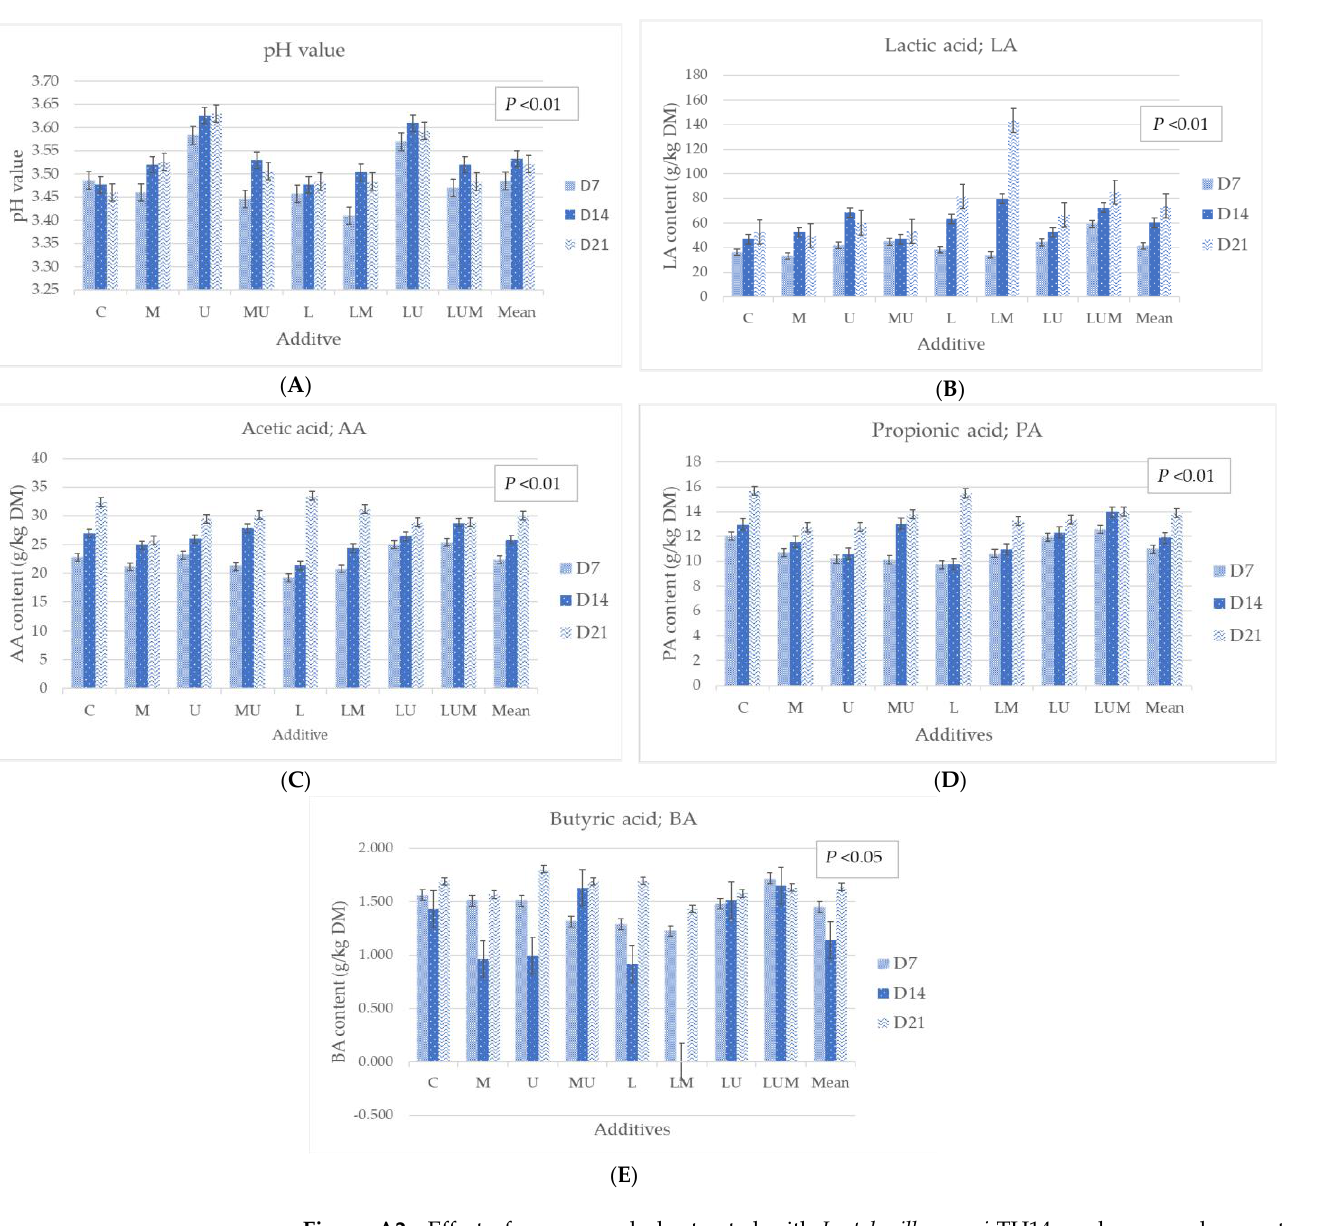
Figure A2. Effect of cassava pulp by treated with Lactobacillus casei TH14, molasses, and urea at different days and the mean of each day of fermentation on ( A ) pH value, ( B ) lactic acid; LA, ( C ) acetic acid; AA, ( D ) propionic acid; PA, and ( E ) butyric acid; BA. CON = no additive, M= treated with molasses 4% DM, U = treated with urea 4% DM, UM = treated with urea 4% DM and molasses 4% DM, L = treated with LcTH14 105 cfu/kg FM, LM = treated with LcTH14 10 5 cfu/kg FM and molasses 4% DM, LU = treated with LcTH14 10 5 cfu/kg FM and urea 4% DM, and LUM = treated with LcTH14 10 5 cfu/kg FM, urea 4% DM, and molasses 4% DM, DM = dry matter, ammonia-N = ammonia nitrogen, D7 = after 7 days of fermentation, D14 = after 14 days of fermentation, D21 = after 21 days of fermentation, p -value by the effect of the day of fermentation.